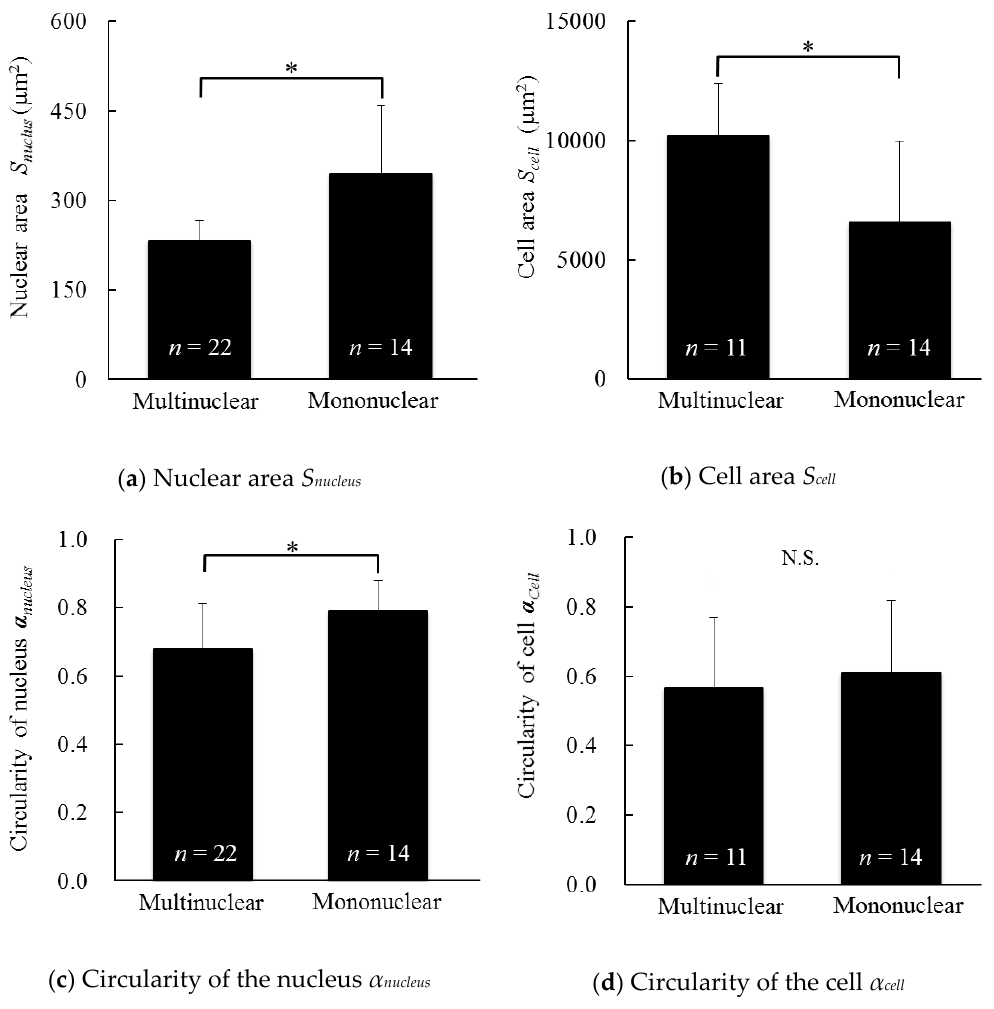
Figure 6. Morphology of multinucleated and mononuclear XTC-YF cells 48 h after seeding on the less hydrophilic glass bottom dish. Morphological data, such as ( a ) the nuclear area, ( b ) cell area, ( c ) circularity of the nucleus, and ( d ) circularity of the cell, are shown. n , Number of nuclei; *, p < 0.05.